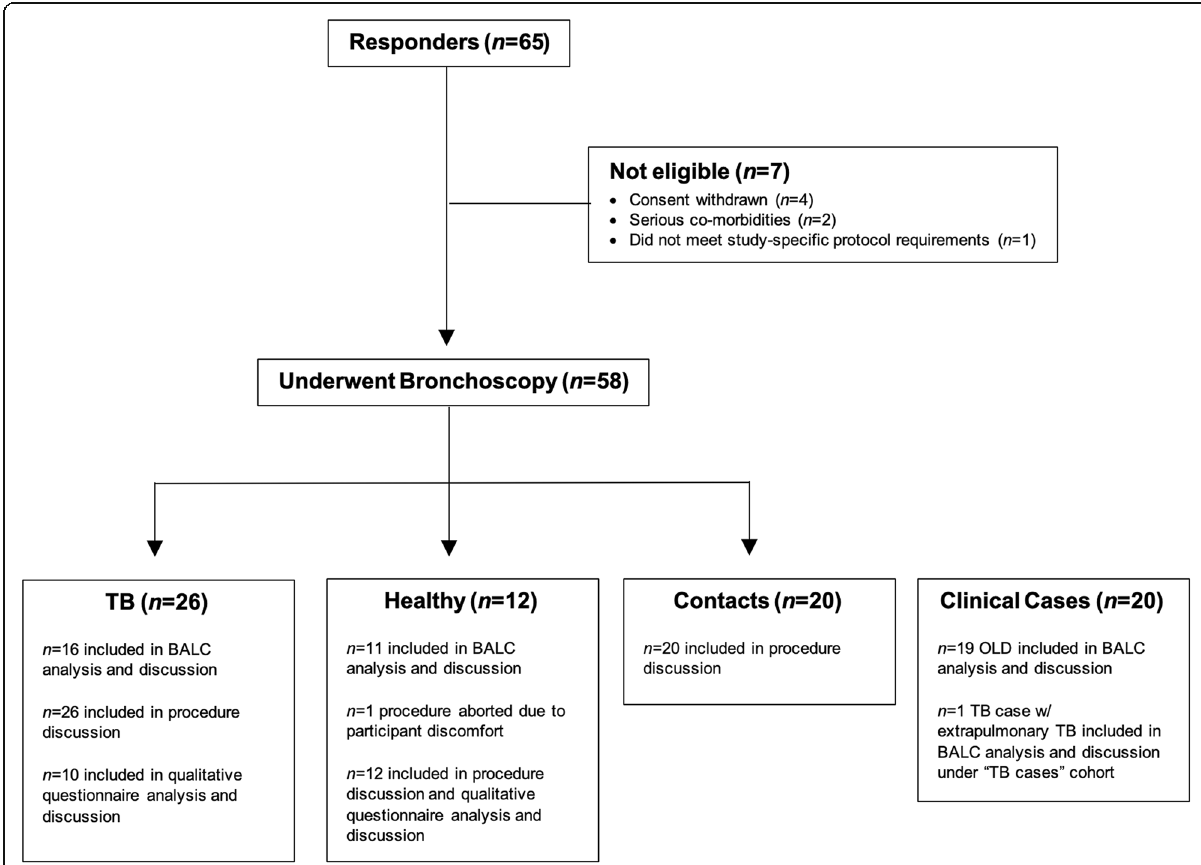
Fig. 1 Standards for reporting of diagnostic accuracy (STARD) diagram illustrating study design and participant classification. TB group encompassed confirmed PTB patients with radiographical evidence, positive GeneXpert and confirmed Mtb sputum culture. Healthy community controls had no evidence of TB or other diseases. TB Contacts group had close contact with an active TB patient and included a subset of 12 participants with Diabetes Mellitus. OLD group presented with various respiratory diseases and included HIV infected participants. STARD = standards for reporting of diagnostic accuracy; TB = tuberculosis; PTB = pulmonary TB; Mtb = Mycobacterium tuberculosis; OLD = other